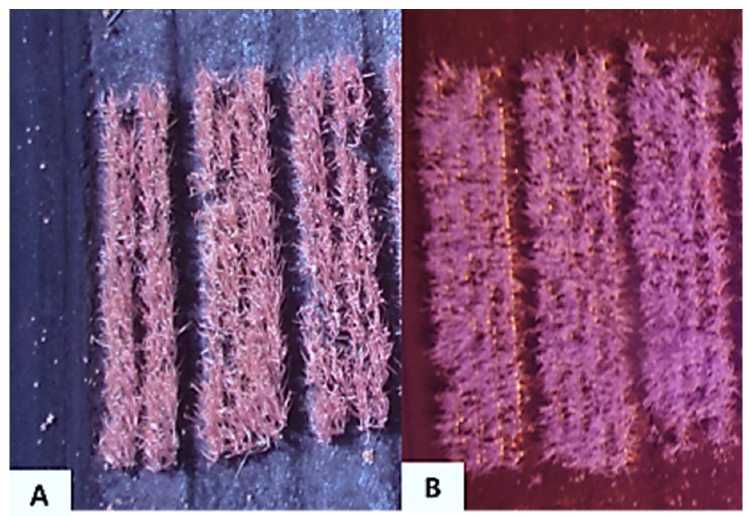
Figure 3. Aerial infrared image of onion trials taken on 4 August 2016 with a Xnite-Canon SX230NDVI camera with ( A ) the red-filter or ( B ) blue-filter replaced with a near-infrared filter at the Muck Crops Research Station, Holland Marsh,